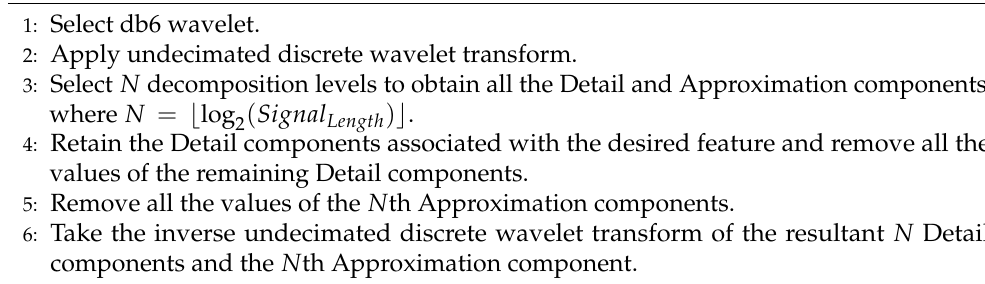
Algorithm 1 Adapted NERD Algorithm for